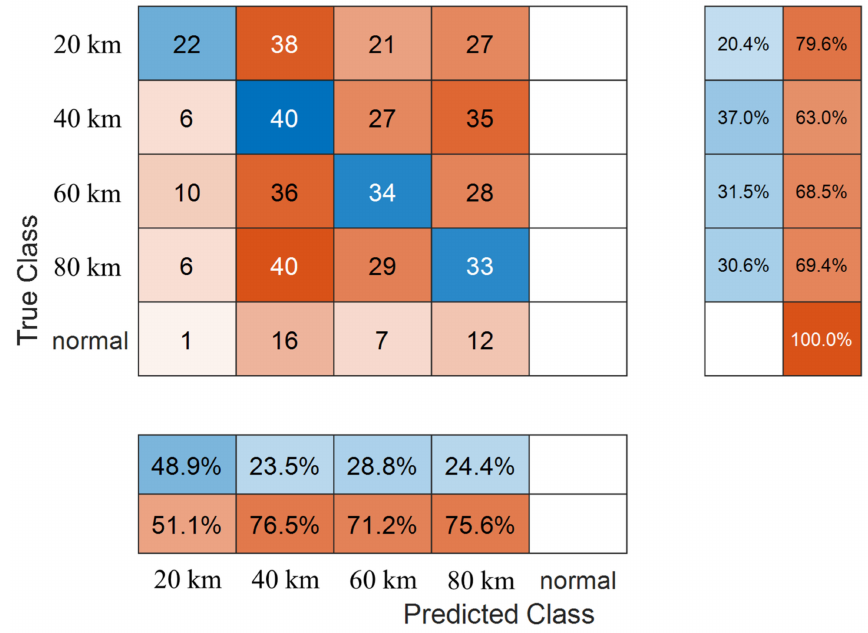
Figure 12. Confusion matrix of fault location classification model with 1/4 cycle data